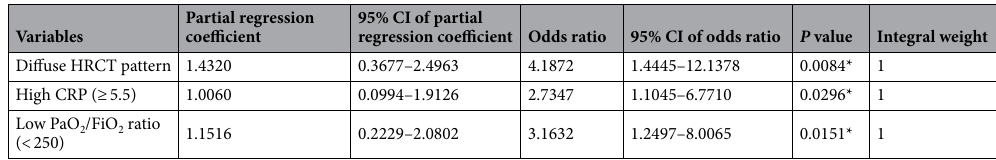
Table 3. Results of multivariate logistic regression analysis with categorized selected variables. CI, confidence interval; HRCT, high-resolution computed tomography; CRP, C-reactive protein. * P < 0.05.